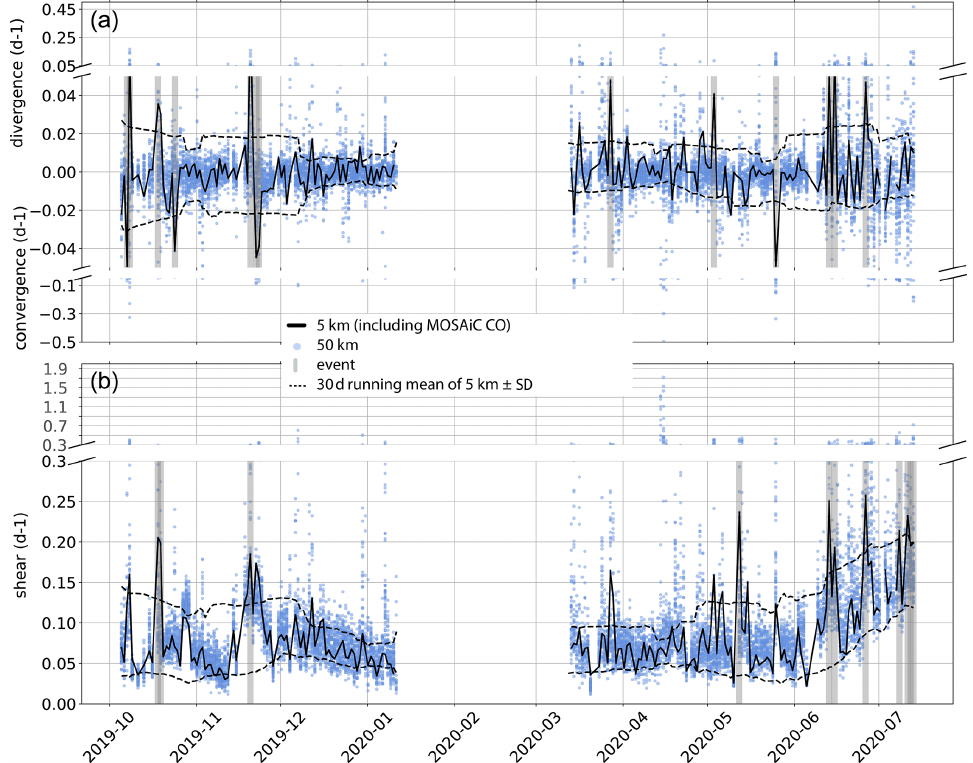
Figure 17. Time series of (a) divergence, convergence and (b) shear extracted from Sentinel-1 SAR scenes along the MOSAiC drift at different radii (5km in black vs. 50km in blue; compare Fig. 3) between 5 October 2019 and 14 July 2020. Strong deformation events with a magnitude of more than 2 standard deviations are marked by vertical gray bars. Successive events might overlap and look like one event. The 30d running mean ± standard deviation illustrates the seasonal variability. Please note the change in the y axes’ spacing to better display the larger deformation rates in spring and